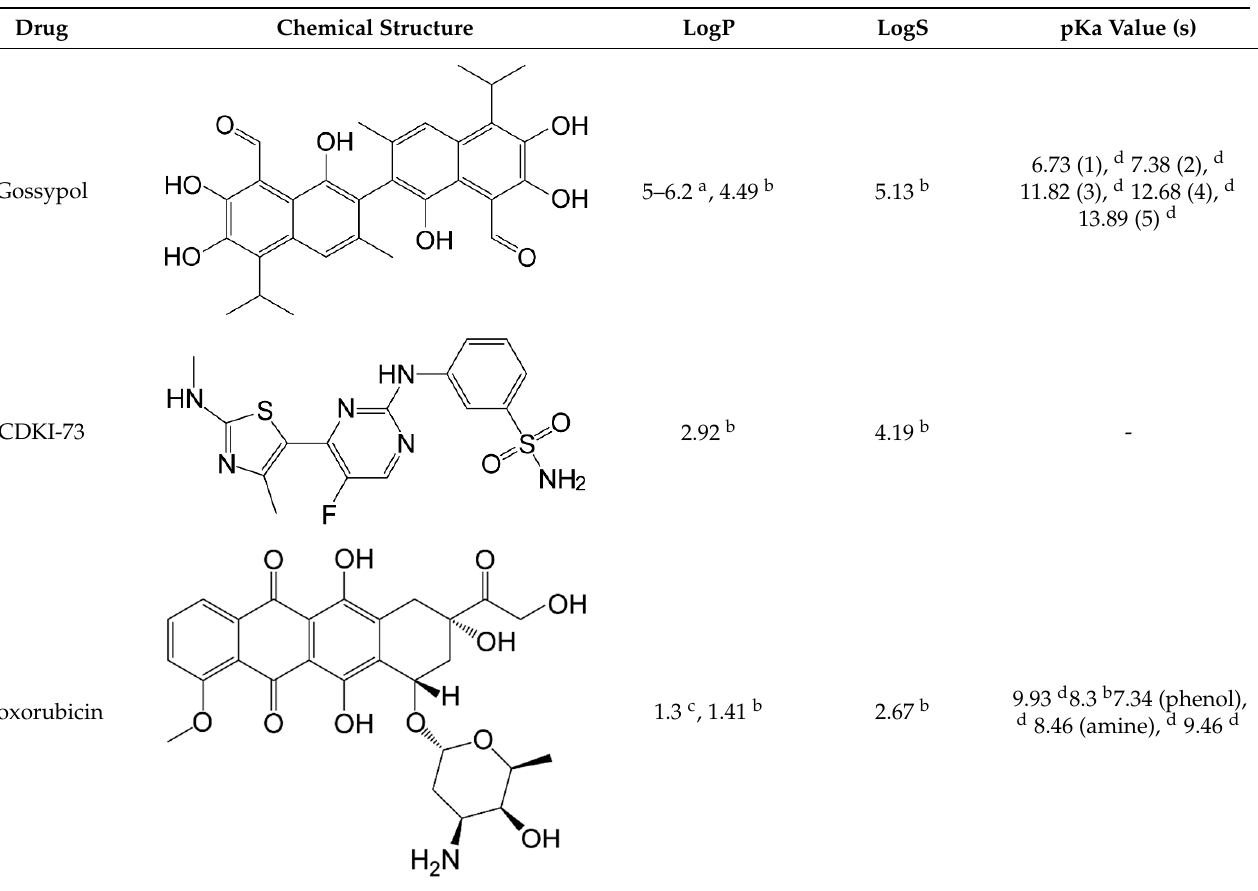
Table 2. Structures and summary of the physicochemical properties of the encapsulated hydrophobic drugs.